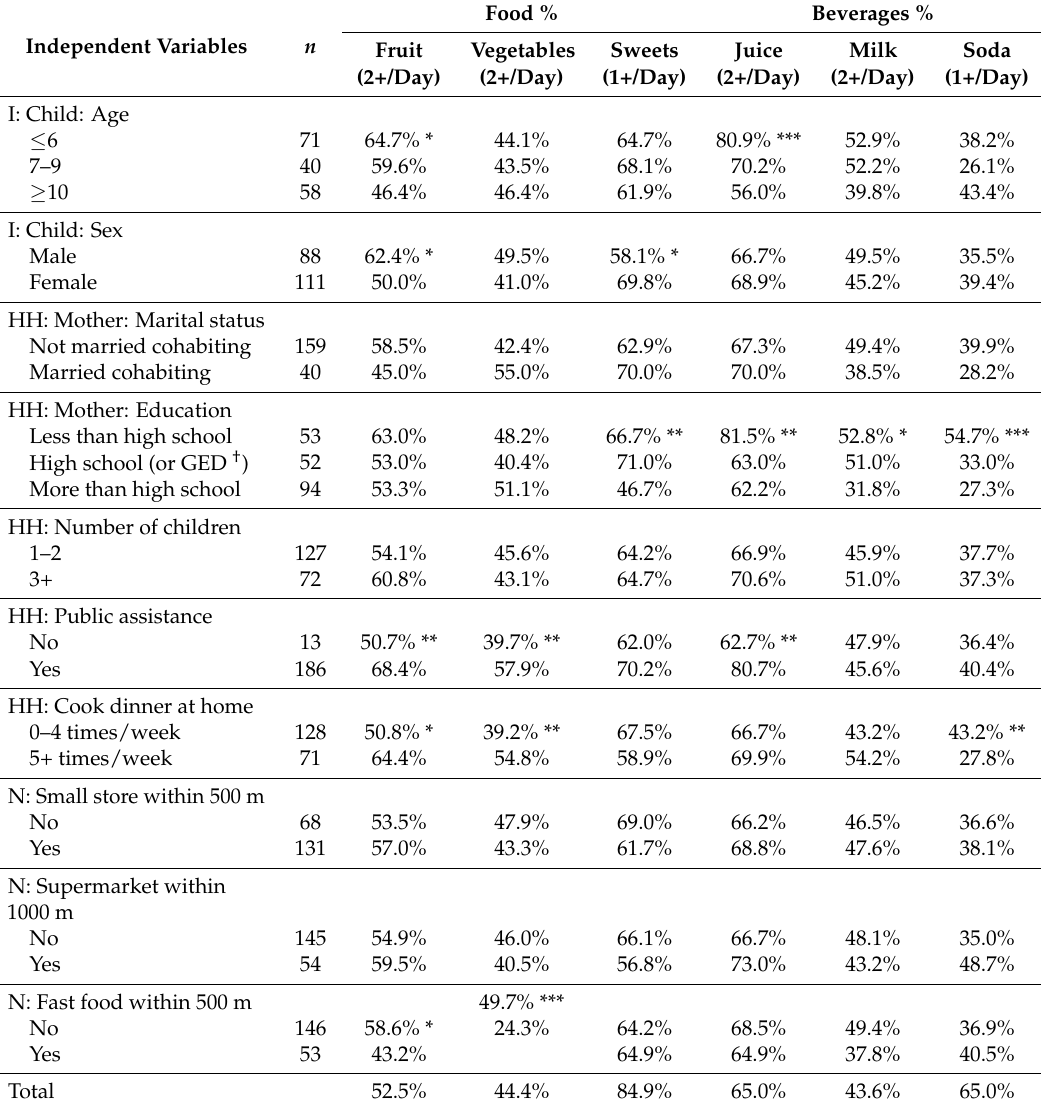
Table 1. Food consumption by individual, family, and neighborhood characteristics ( N =